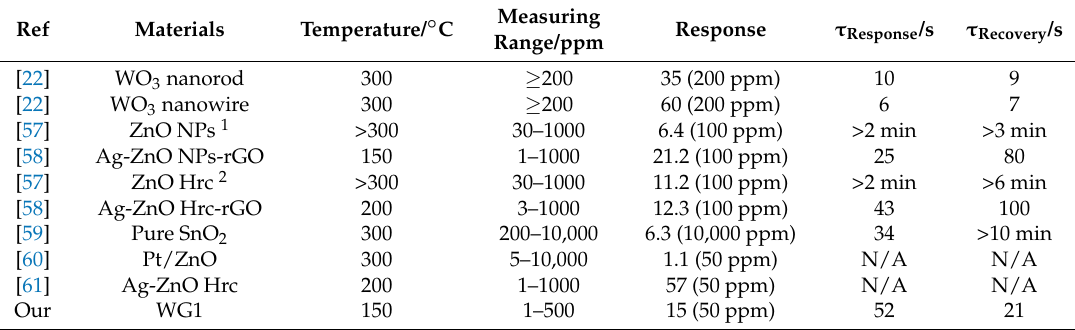
Table 1. Comparison between our work and other reported work on C 2 H 2 gas detection.